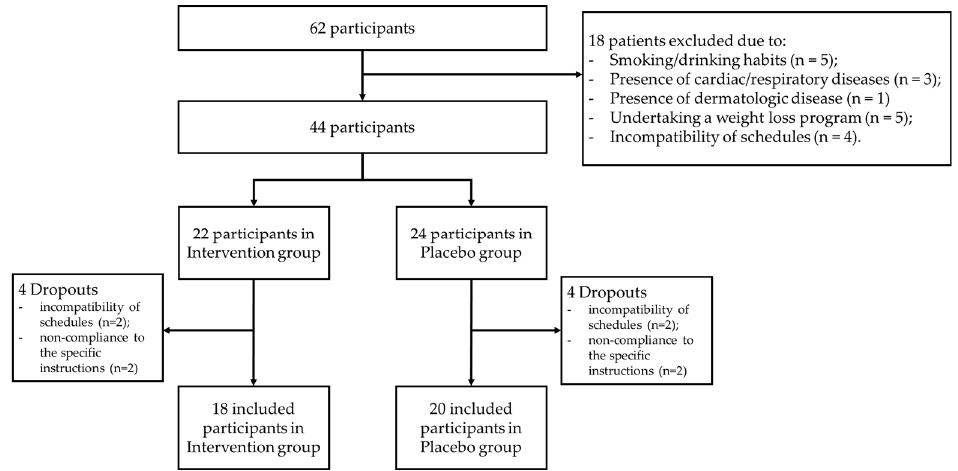
Figure 3. Flow diagram of participants through the study.